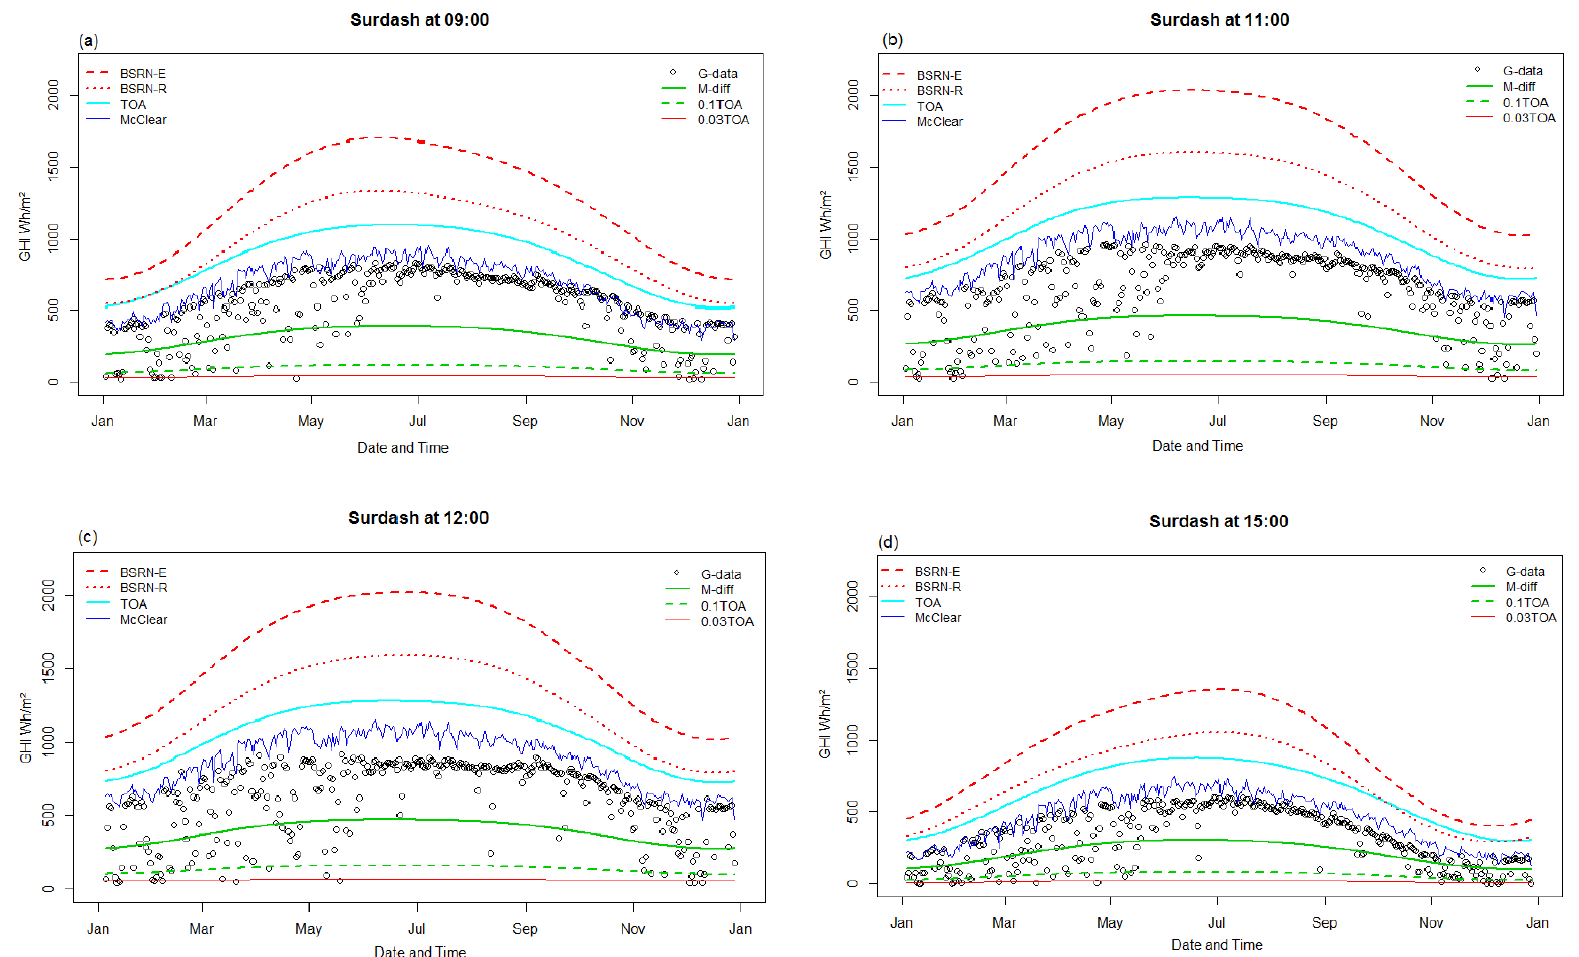
Figure 5. Scatterplots of the limits for tests, namely BSRN physically possible limit (BSRN-E), BSRN extremely rare limit (BSRN-R), TOA, clear sky radiation of McClear model, max possible diffuse is 35% of TOA (M-diff), 10% TOA, 3% TOA and GHI ground data (G-data) for hours namely ( a ) 09:00, ( b ) 11:00, ( c ) 12:00 and ( d ) 15:00 at Surdash station as an example.